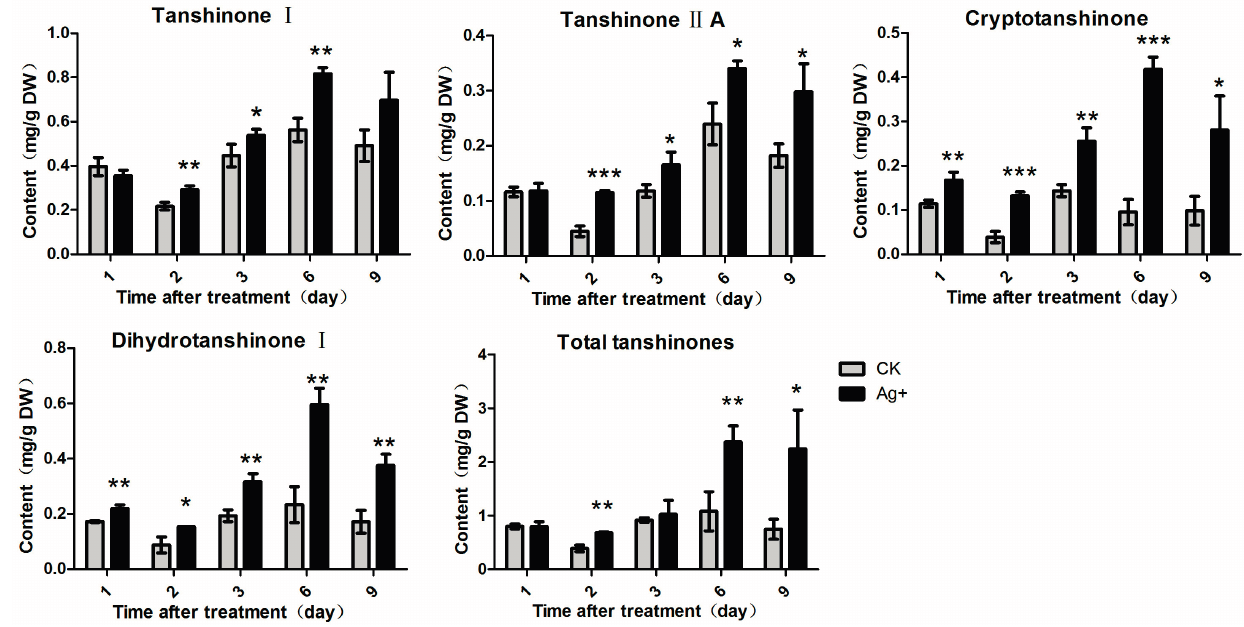
Figure 5. Effects of Ag + on accumulations of tanshinones in S. miltiorrhiza hairy roots. Content of T-I (tanshinone I), T-IIA (tanshinone IIA), CT (cryptotanshinone), DT-I (dihydrotanshinone I) and total tanshinones. The vertical bars show the SD values ( n = 3). The asterisks indicate statistically significant differences at p < 0.05 ( * , 0.01 < p < 0.05; ** , 0.001 < p < 0.01; *** , p < 0.001.) between the content in the elicitor treated cultures and that in the corresponding